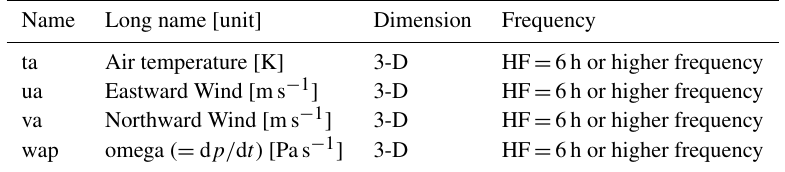
Table A2. Input for a TEM diagnostic program (CMOR